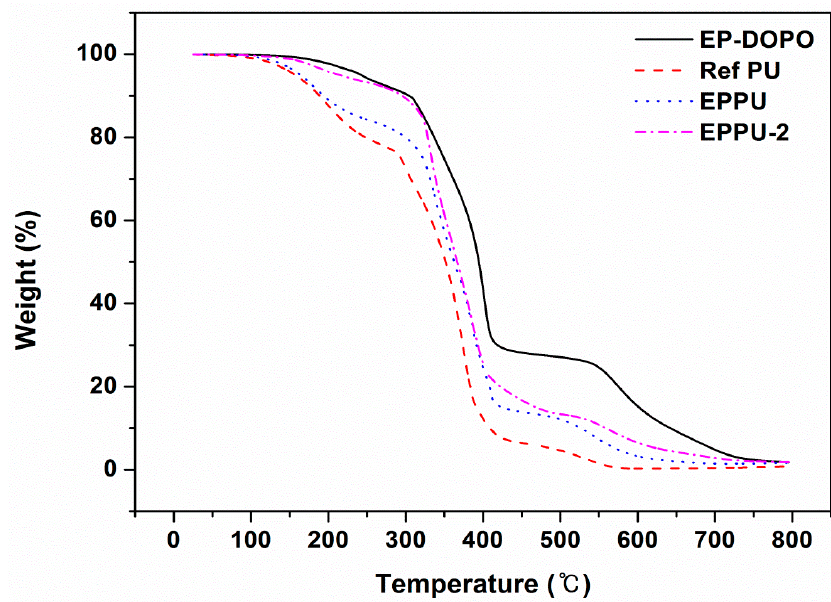
Figure 6. Thermogravimetric analysis (TGA) data for Ref PU and EPPU in N 2 DOPO: